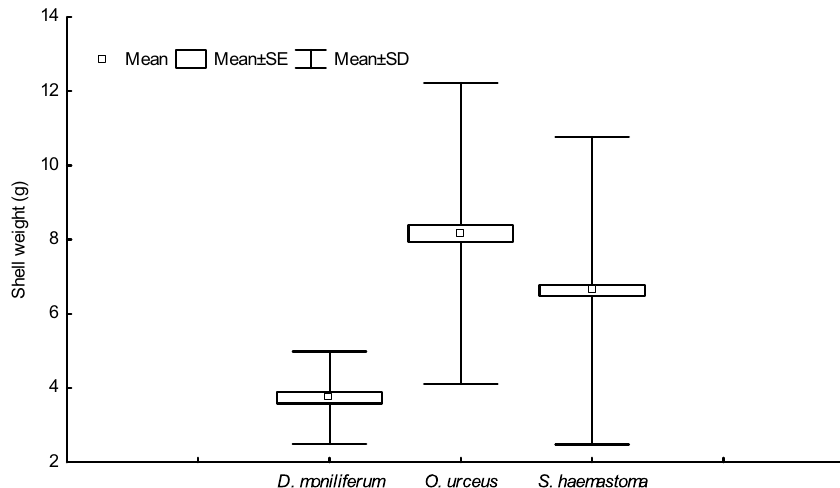
Fig. 1 – Clibanarius vittatus . Mean, standard deviation and standard error of the shell weight of the gastropod species more occupied by hermit